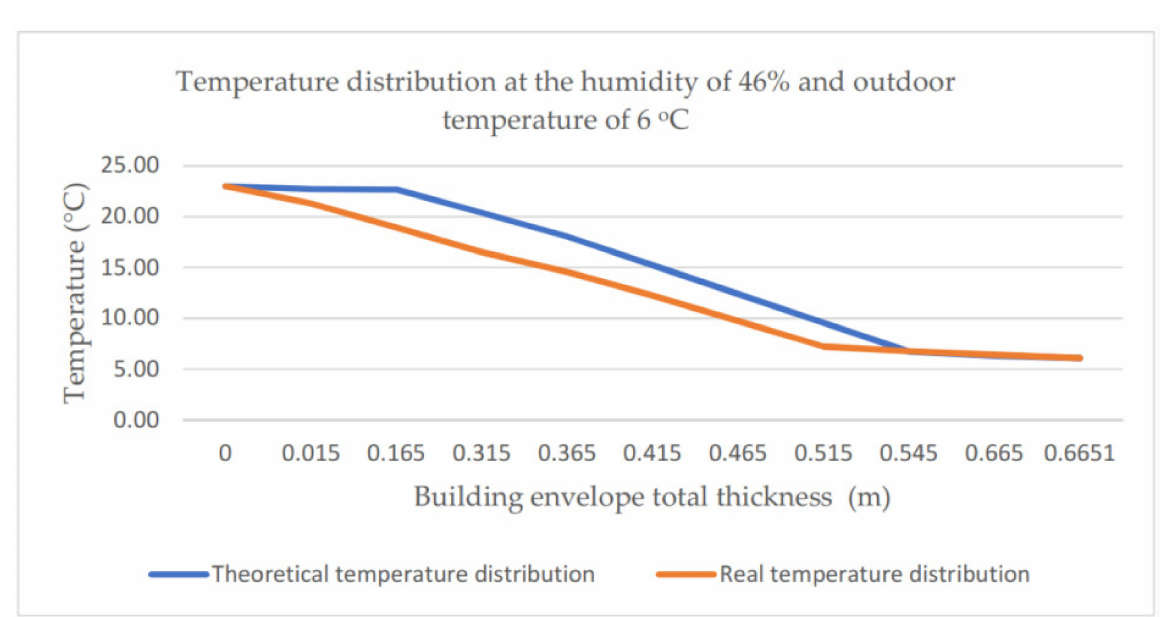
Figure 13. Temperature distribution at the humidity of 46% and outdoor temperature of 6 ◦ C.